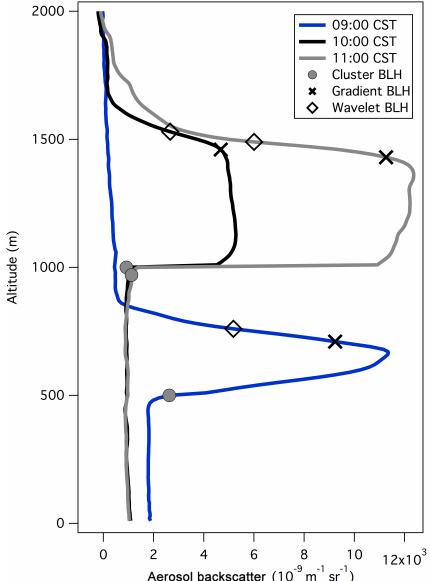
Figure 10. Aerosol backscatter profile for 20 October 2014 at 14:00CST where radiosonde-derived BLH does not correspond to the height of the largest negative gradient in the aerosol backscatter profile. Radiosonde BLH at 1290m is shown as a grey circle, and wavelet-method-derived BLH at 1510m is shown as a red circle.